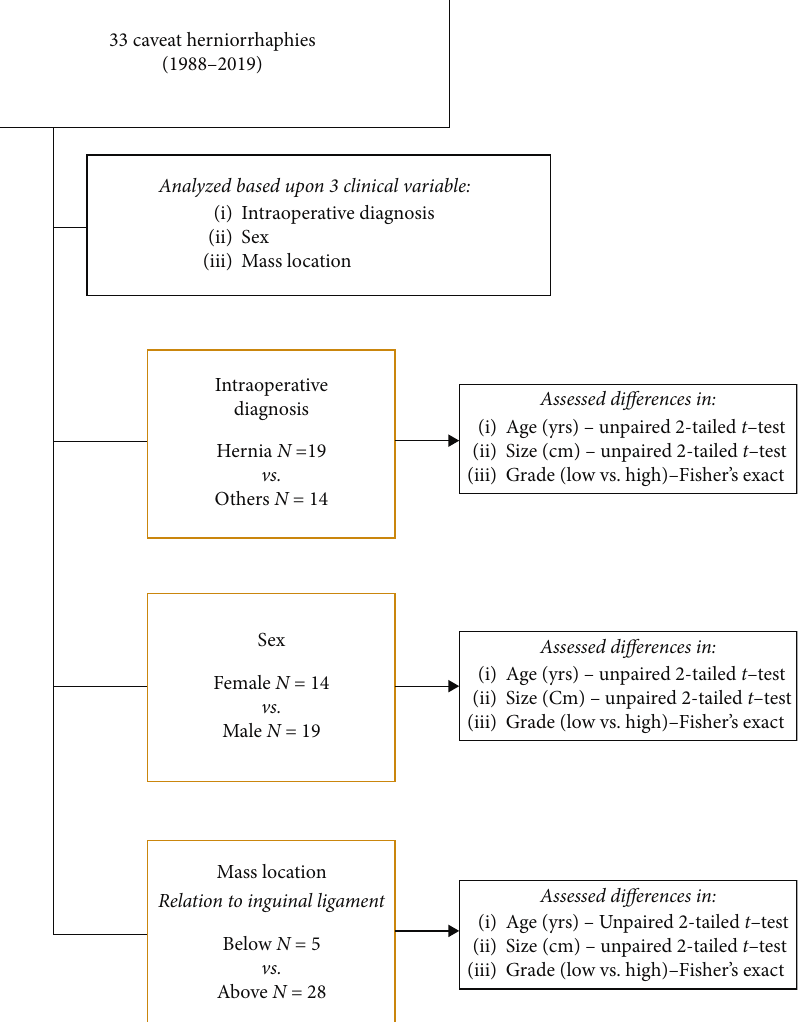
Figure 1: Study groups and